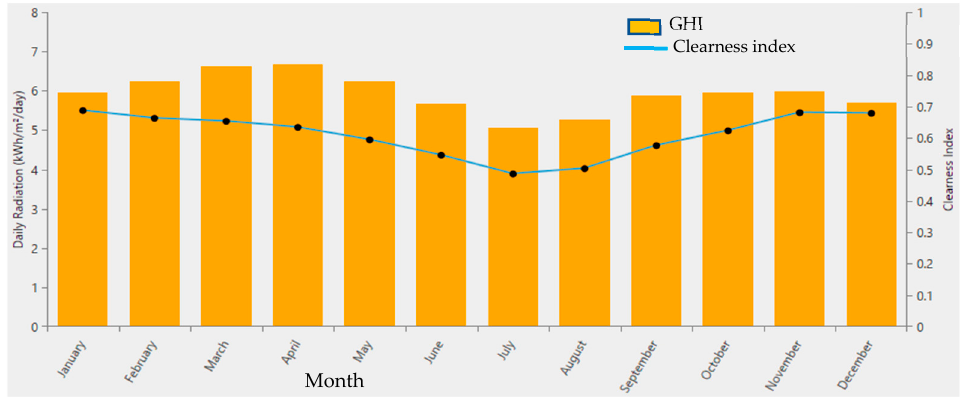
Figure 3. Average global horizontal irradiation data.